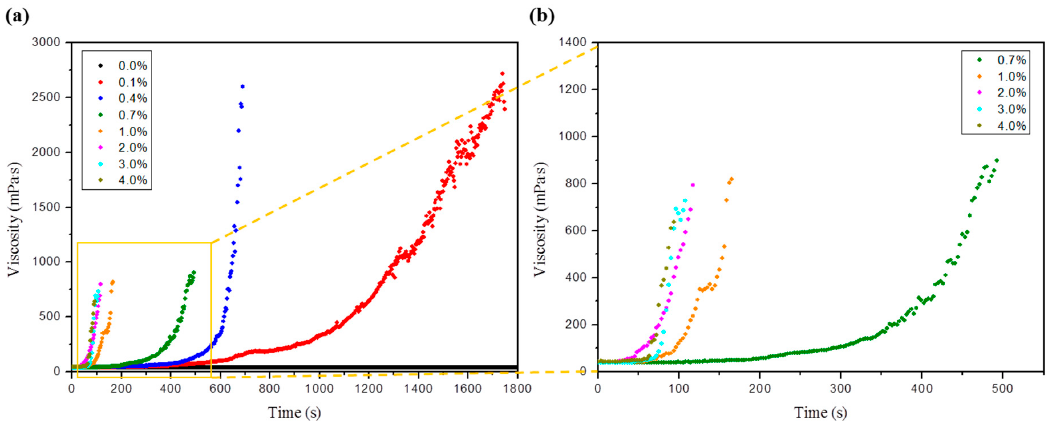
Figure 4. Viscosity change of SF gel depending on concentration of NaNO 3 : ( a ) viscosity change of SF gel from 0% to 4% NaNO 3 concentrations and ( b ) the expanded viscosity change of SF gel at high NaNO 3 concentrations (from 0.7% to 4%).